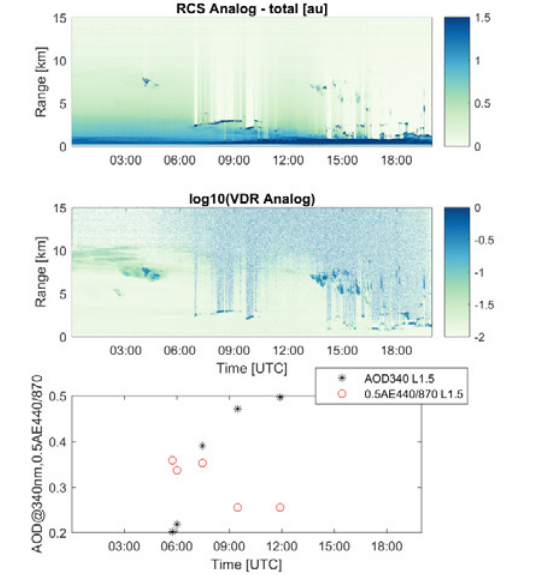
Figure 3. RCS (upper), VDR (middle) and AOD and AE (lower) at Camborne on 26/05/2016 during a biomass burning event.